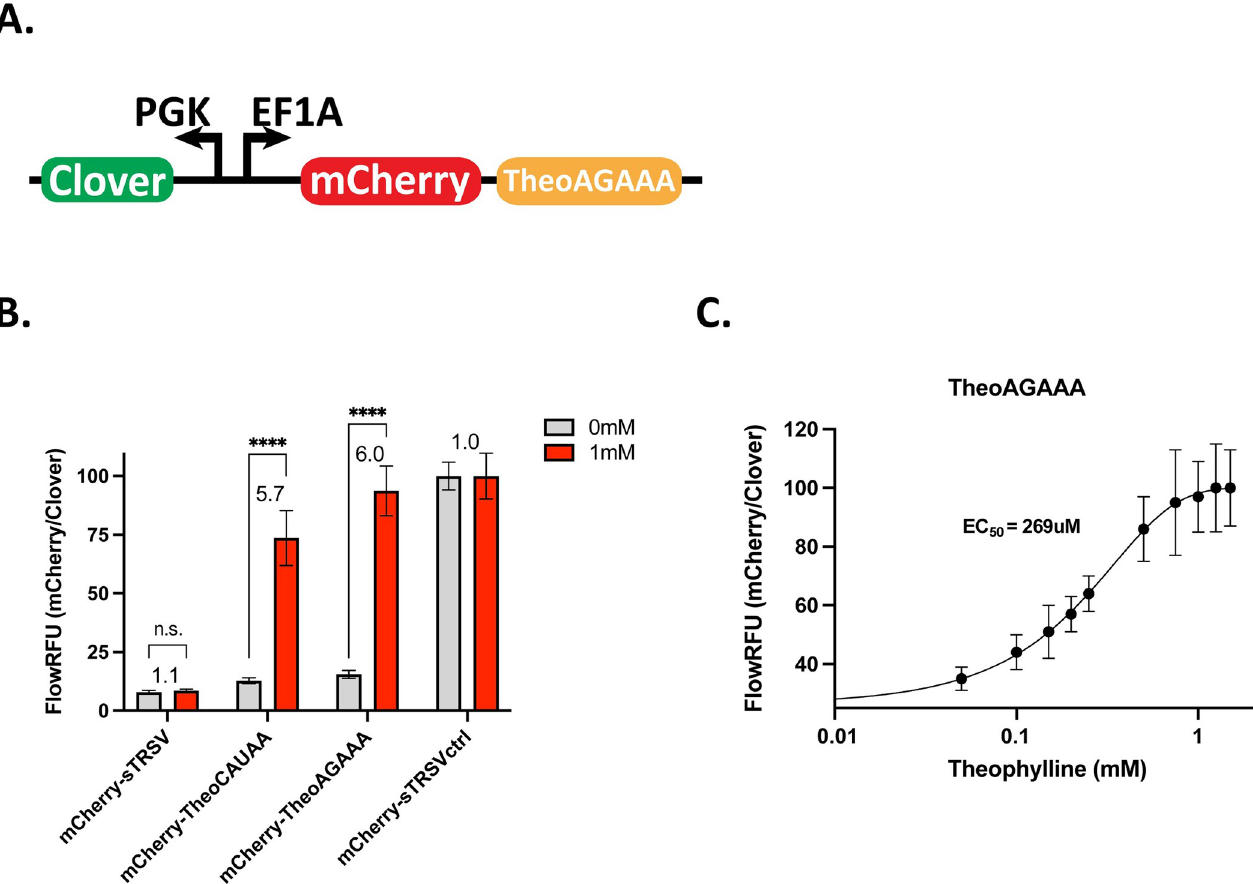
Fig 2. Theophylline-responsive ribozyme switches demonstrate activity in myoblasts. A. Diagram of a bicistronic fluorescent reporter construct. mCherry expression driven by an EF1 α promoter is controlled by a theophylline-responsive switch. Clover expression driven by a PGK promoter offers a transfection control for normalization. B. Flow cytometry analysis of multiple theophylline-responsive ribozyme switches. For each sample, the mean fluorescence intensity of mCherry was normalized by the mean fluorescence intensity of Clover to give the mean fluorescence ratio. The mean fluorescence ratio was normalized to that of the non-cleaving sTRSVctrl and scaled by a factor of 100 to give relative fluorescence values (FlowRFU). Activation ratio (AR) of mCherry/Clover representing fold change of normalized mCherry expression is indicated above each set of bars. sTRSV is the wild-type hammerhead ribozyme; sTRSVctrl is a non-cleaving mutant of sTRSV; error bars indicate standard deviation of four biological replicates; asterisks indicate significance based on p-values from t-test, n.s. indicates not significant, � p < 0.01, �� p < 0.001, ��� p < 0.0001, ���� p < 0.00001. C. Dose response curve for the TheoAGAAA ribozyme switch showing relative fluorescence values as a function of theophylline concentration. EC 50 value reported as mean of four biological replicates; error bars indicate standard deviation of four biological replicates. https://doi.org/10.1371/journal.pone.0275298.g002 Initial characterization of HRAS and JAK1 as anti-differentiation signals in the C2C12 model cell line was performed by designing constructs with either HRAS or JAK1 linked to the sTRSVctrl non-cleaving ribozyme control for achieving the maximal expression state. C2C12 cells were transiently transfected with the HRAS- and JAK1-overexpression constructs and grown in growth medium for two days until the cells were 80–90% confluent. Cells were then switched to differentiation medium for three days. Cells were then imaged to assess differentia- tion extent. The ratio of cell nuclei associated with MyHC+ myofibers relative to the total number of cell nuclei (i.e., the fusion index) was determined for each group. HRAS-sTRSVctrl expression demonstrated a 64% decrease in the fusion index compared to wild-type negative controls (Fig 3B and 3C). The number of total cell nuclei observed increased 129%, consistent with a promotion of proliferation by HRAS in addition to the inhibition of differentiation (Fig